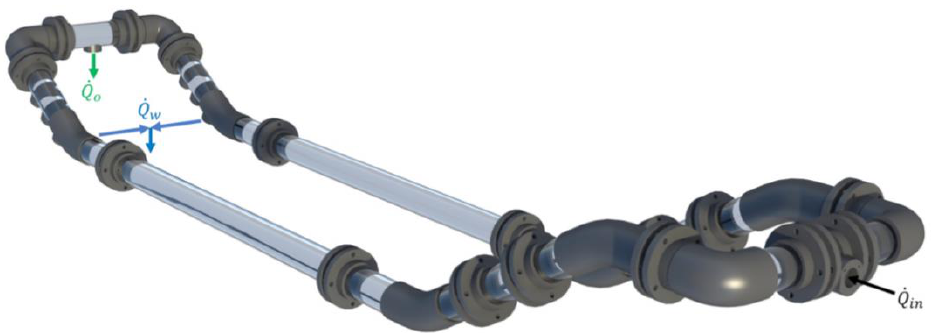
Figure 6. Prototype of parallel pipe bulk oil – water separator.